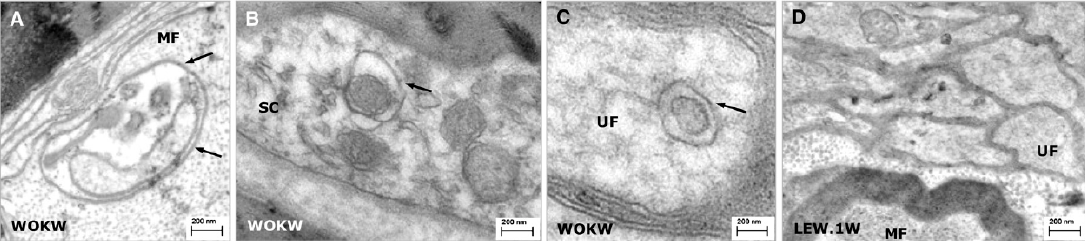
Figure 5. Ultrastructural images of sciatic nerves of five-month-old LEW.1W and WOKW rats. ( A – C ) Numerous autophagosomes (arrows) were found within the myelinated and unmyelinated nerve fibers and in Schwann cells of WOKW rats sciatic nerves; ( D ) Myelinated and unmyelinated nerve fibers visualized in sciatic nerves of LEW.1W rats (figures taken from Kosacka et al. [37] with permission). Abbreviations: LEW.1W, Lewis 1W; MF, myelinated fiber; SC, Schwann cells; UF, unmyelinated fibers; WOKW, Wistar Ottawa Karlsburg W.